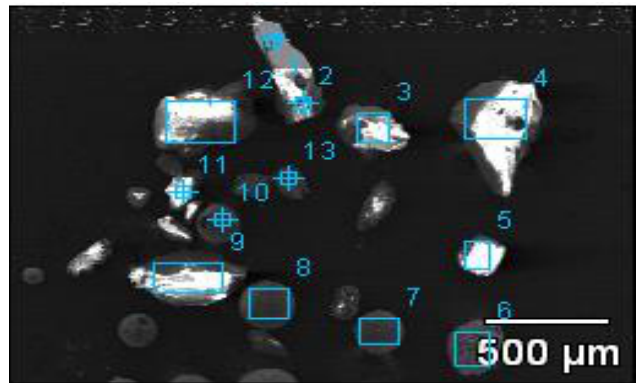
Figure 8. Morphology of macro-inclusions in sample.